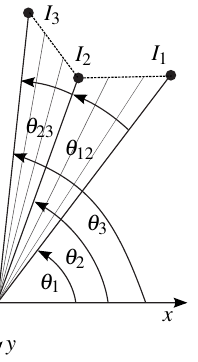
Figure 3: Calculating of the angles and the corresponding laser rays between the